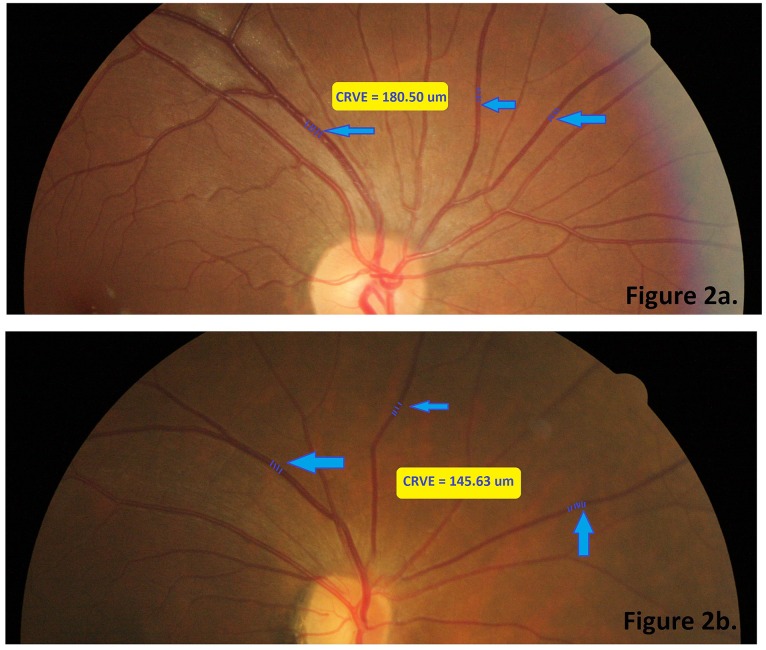
Examples of retinal venular assessment from two subjects with different diet quality.Subject in Fig 2a in the upper panel has a unhealthier diet pattern than the subject in Fig 2b. in the lower panel. Comparisons between 2a and 2b are listed below: total mono-unsaturated fat (MUFA) percentage—80.25% vs. 13.45%; total fat intake percentage– 41.8% vs. 36.9%; Health Eating Index for Asian Pregnant Women (HEI-AP)– 27.20 vs. 38.70; central retinal venular equivalent (CRVE)– 180.50 μm vs 145.63 μm.